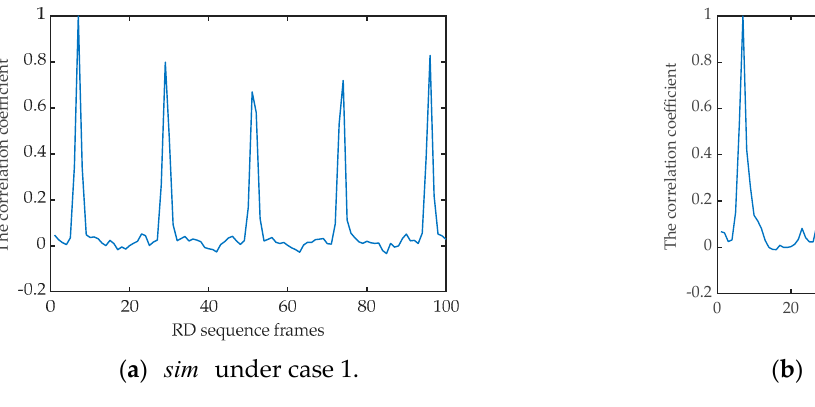
Figure 6. RD sequence similarity estimation.